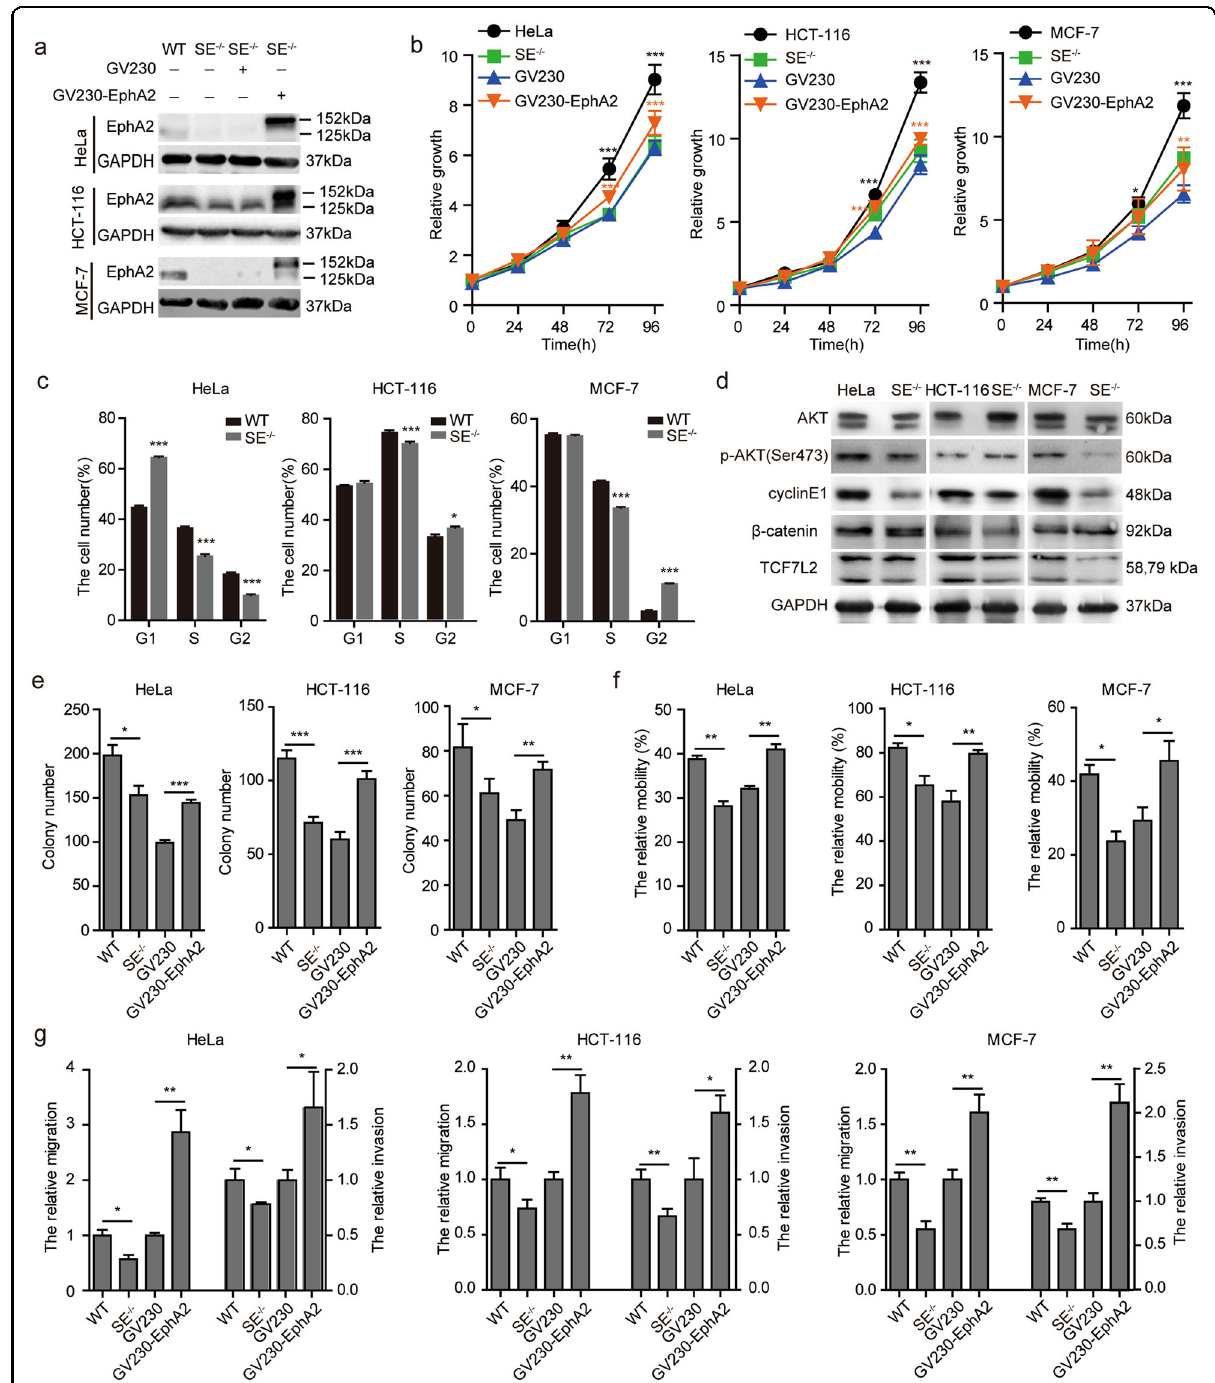
Fig. 4 EphA2-SE knockout inhibited proliferation and migration of HeLa, HCT-116, and MCF-7 cells. a Expression level of EphA2 as measured by western blotting in Hela, HCT-116 and MCF-7 cells. The overexpression vector GV230-EphA2 was constructed to express EphA2-EGFP fusion protein, and then transfected into the EphA2-SE homozygous deletion SE − / − cell lines. b Cell proliferation was measured using MTT assay after EphA2-SE knockout and EphA2 overexpression. c Flow cytometry was used to detect the cell cycle of HeLa, HCT-116 and MCF-7 cells. d Effect of EphA2-SE deletion on PI3K-AKT signaling pathway. e The summary graphs of the number of colonies counted. f The migration distance was calculated. g Migration and invasion ef fi ciency measured by transwell assay. Error bars, mean ± SD. n ≥ 3. p values were calculated using t -test. * p < 0.05, ** p < 0.01, *** p < 0.001. WT: wild type cell; SE − / − : EphA2-SE homozygous deletion; GV230 SE − / − : Cells transfected with empty vector GV230; GV230-EphA2-SE − / − : Cell lines overexpress